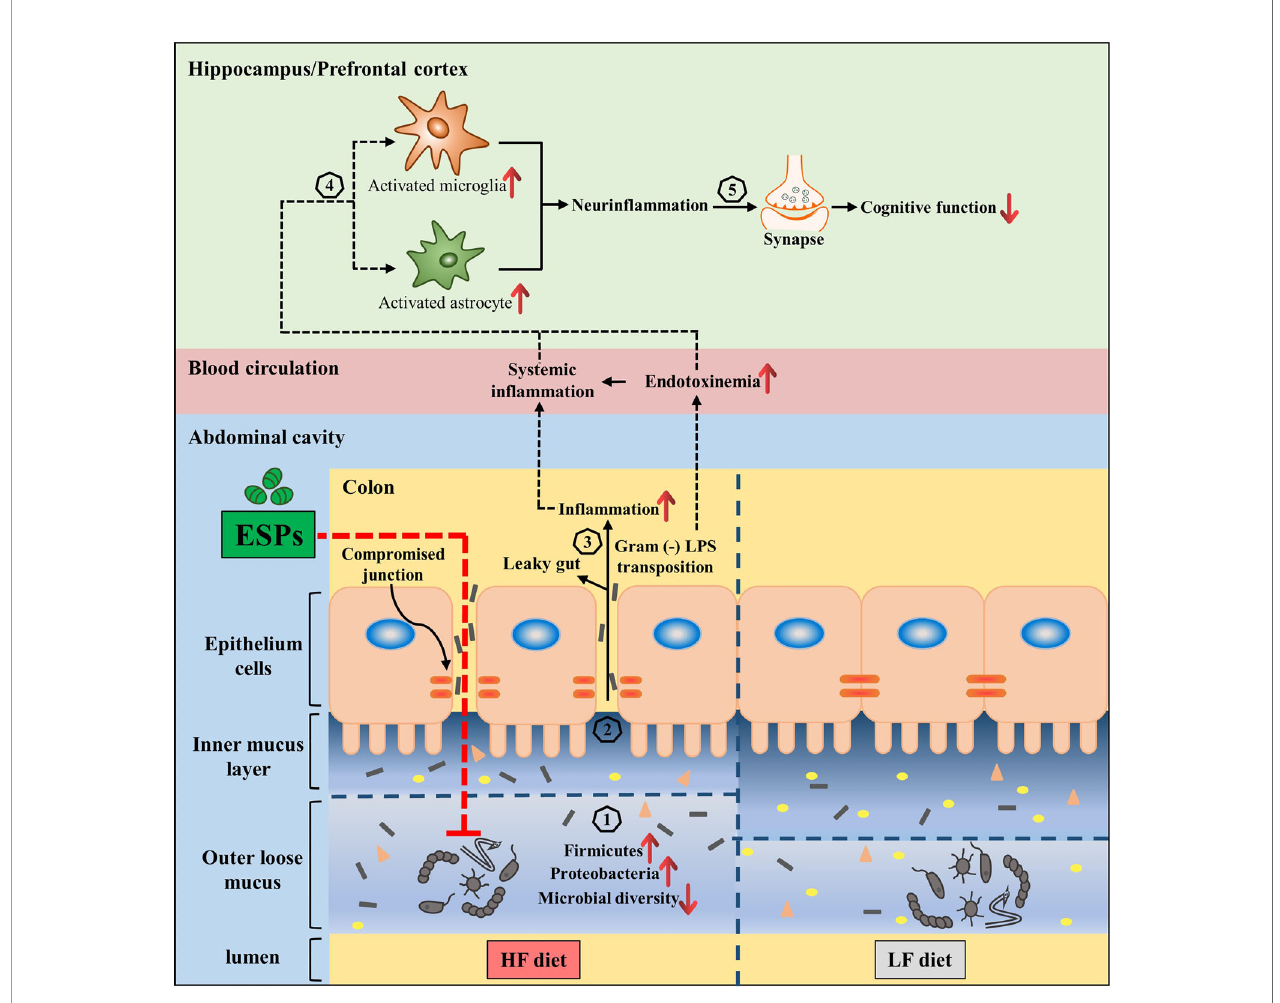
FIGURE 7 | Interplay between the microbiota and gut-brain axis in high-fat diet and ESPs intervention. Gut microbiota regulates the gut-brain axis to maintain good health, while its alteration (increased of Firmicutes and Proteobacteria, decrease of Bacteroidetes and microbial diversity) due to HF diet is related to obesity, which has adverse consequences on cognition (Steps 1 – 5). ESPs supplementation is thought to decrease Firmicutes and Proteobacteria, while increasing the microbial diversity (1), thereby maintaining the gut mucus and epithelial integrity as well as immune homeostasis (2); this attenuates the translocation of LPS (3), which decreases the peripheral in fl ammatory tone and inhibits the activation of microglia and astrocytes, causing neuroin fl ammation (4) and synaptic damage in the central nervous system (5). Therefore, the supplementation of ESPs has a bene fi cial impact on cognition via restoration of the gut microbiota and its regulatory role in the gut-brain